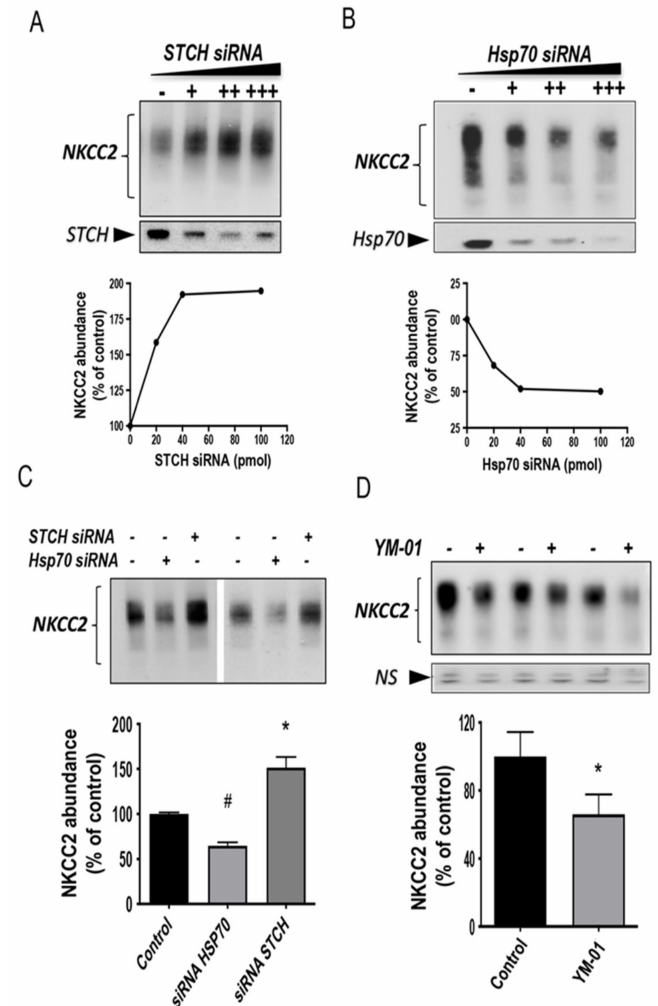
Figure 8. Differential regulation of NKCC2 expression by endogenous Hsp70 and STCH. ( A , B ) Knockdown of endogenous STCH or Hsp70 in HEK cells regulate total NKCC2 protein abundance in a dose-dependent fashion. Upper panels , representative immunoblot analysis of two independent experiments illustrating the effect of STCH knockdown ( upper left panel ) or Hsp70 knockdown ( lower right panel ) on NKCC2. HEK cells were transfected with NKCC2 in the absence (-) or presence of an increasing amount (+, ++, +++) of specific STCH siRNA or Hsp70 siRNA. 48 h post- transfection, total cell extract from each sample was run on a parallel SDS gel and Western blotted for total NKCC2 expression. NKCC2 proteins were detected by immunoblotting with Myc antibody. Lower panels , densitometric analysis of total NKCC2 proteins. Data are expressed as percentage of control ( n = 2). ( C ) Opposite effects of STCH and Hsp70 knockdowns on total NKCC2 protein. Representative immunoblot analysis showing the effect of Hsp70 knockdown and STCH knockdown on total NKCC2. HEK cells were transfected with NKCC2 in the absence ( − ) or presence of specific Hsp70 siRNA (+) or STCH siRNA (+). Then, 48 h post-transfection, total cell extract from each sample was subjected to immunoblotting analysis. Lower panel , densitometric analysis of total NKCC2 proteins. Data are expressed as percentage of control. Each point represents mean ± SE from four independent experiments ( n = 4). #, p < 0.05 versus control. *, p < 0.003 versus control. ( D ) Effect of Hsp70 inhibitor YM-01 on NKCC2. HEK cells transfected with NKCC2 were treated with 1 µ M of YM-01 (+) or without ( − ) overnight before cell lysis and immunoblotting using anti-Myc for NKCC2. NS , a non-specific band illustrating the equal loading of protein extracts. Lower panel , densitometric analysis of total NKCC2 proteins. Data are expressed as percentage of control. Each point represents mean ± SE from three independent experiments ( n = 3). *, p < 0.05 versus